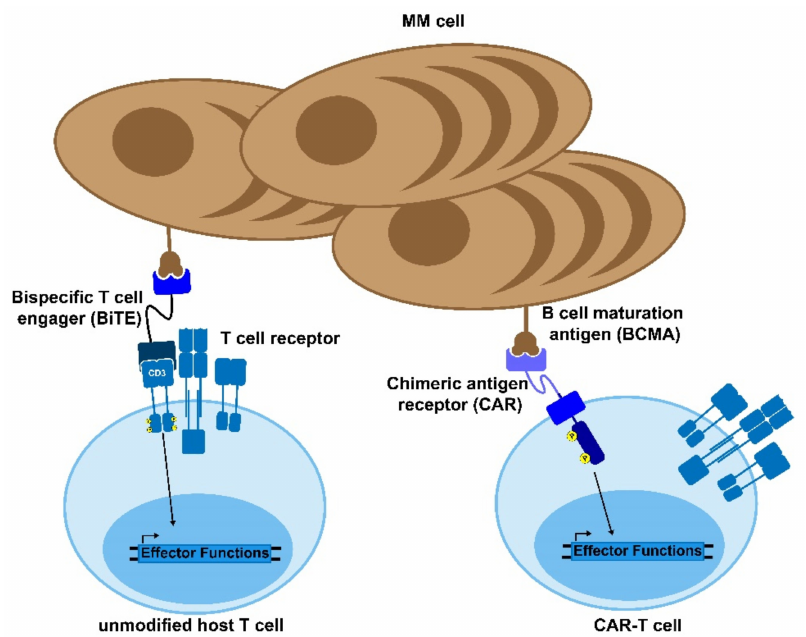
Figure 2. Bi-specific antibodies and CAR-T cells. Bispecific T cell engagers (BiTEs) and chimeric antigen receptor (CAR) T cells are novel therapies to treat MM and other diseases. The BiTE uses two antibody domains to crosslink the target cell to an immune effector cell in order to activate the host immune response against the tumor. Similarly, CAR-T cells are genetically modified to express a chimeric, MM-recognizing antigen that can bypass the normal T cell activation cascade to enable the CAR-T cell to respond to and kill target antigen-expressing